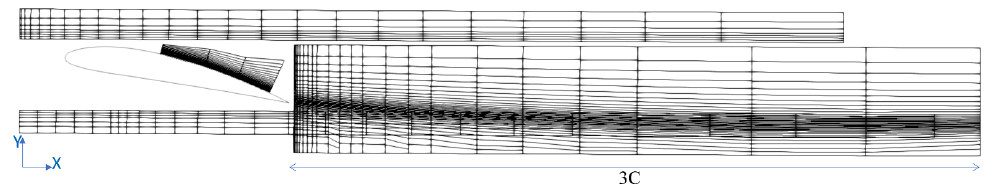
Figure 2. Measurement grid at airfoil plane ( XY ). AOA =11 ◦ is shown; it is similar for the other AOAs depending on their wake